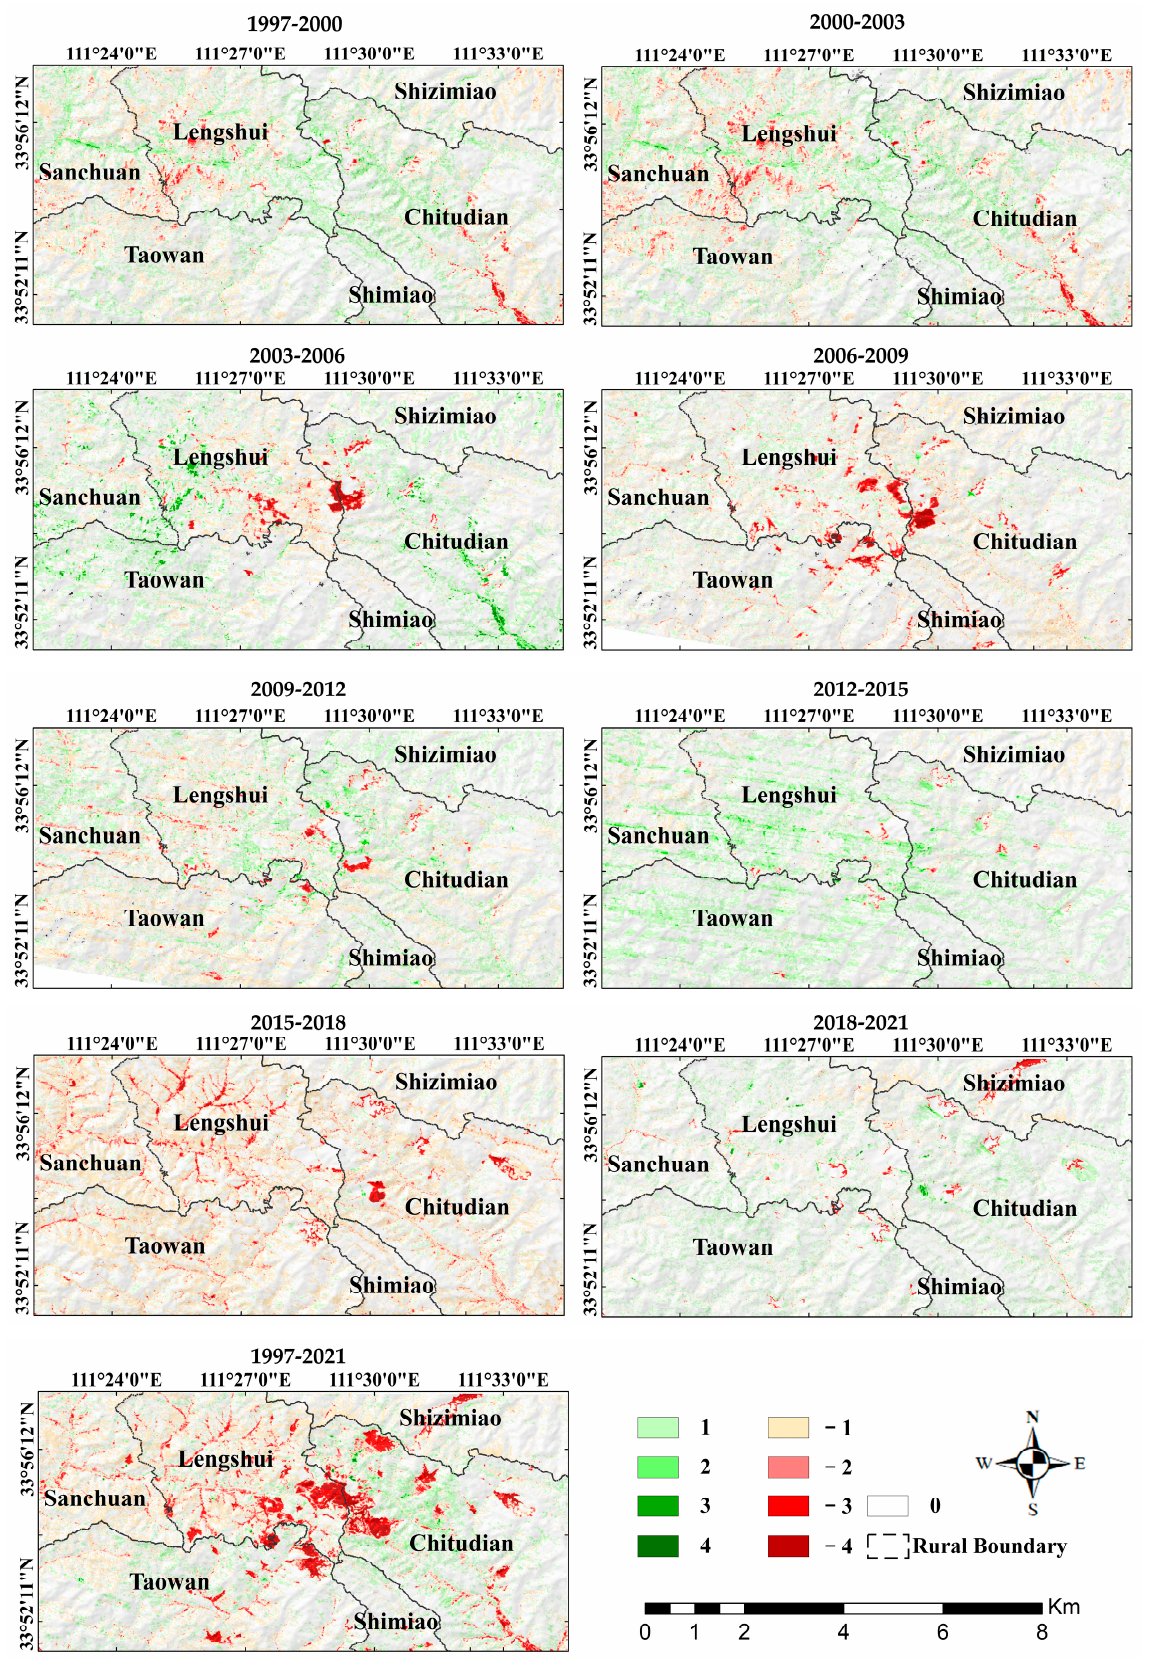
Figure 10. Ecological changes in mining areas in 1997, 2000, 2003, 2006, 2009, 2012, 2015, 2018, and